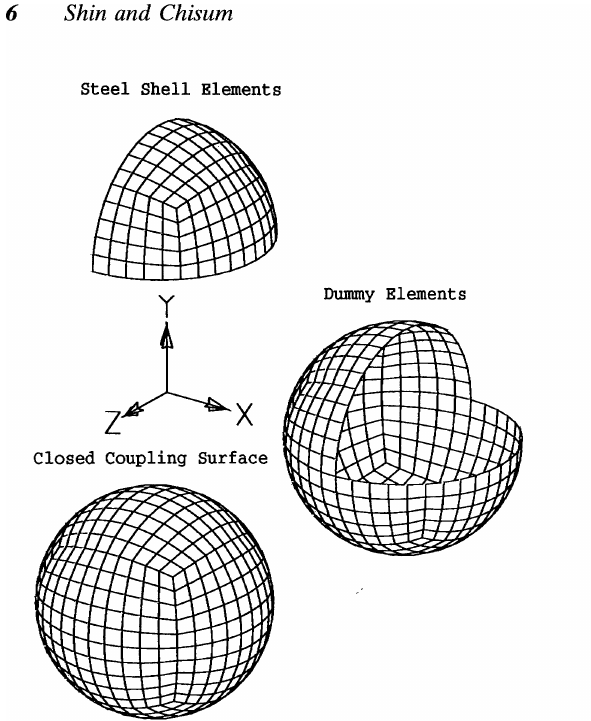
FIGURE 4 Lagrangian shell elements, dummy ele ments, and the resulting closed coupling surface for the spherical shell/plane step wave problem.